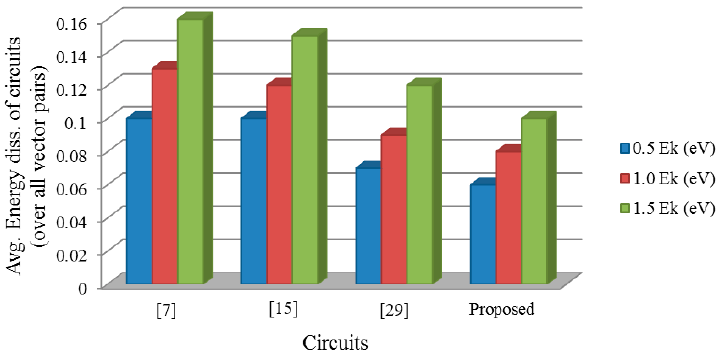
Figure 15. The average energy dissipation of the half adders for various tunneling energy levels.